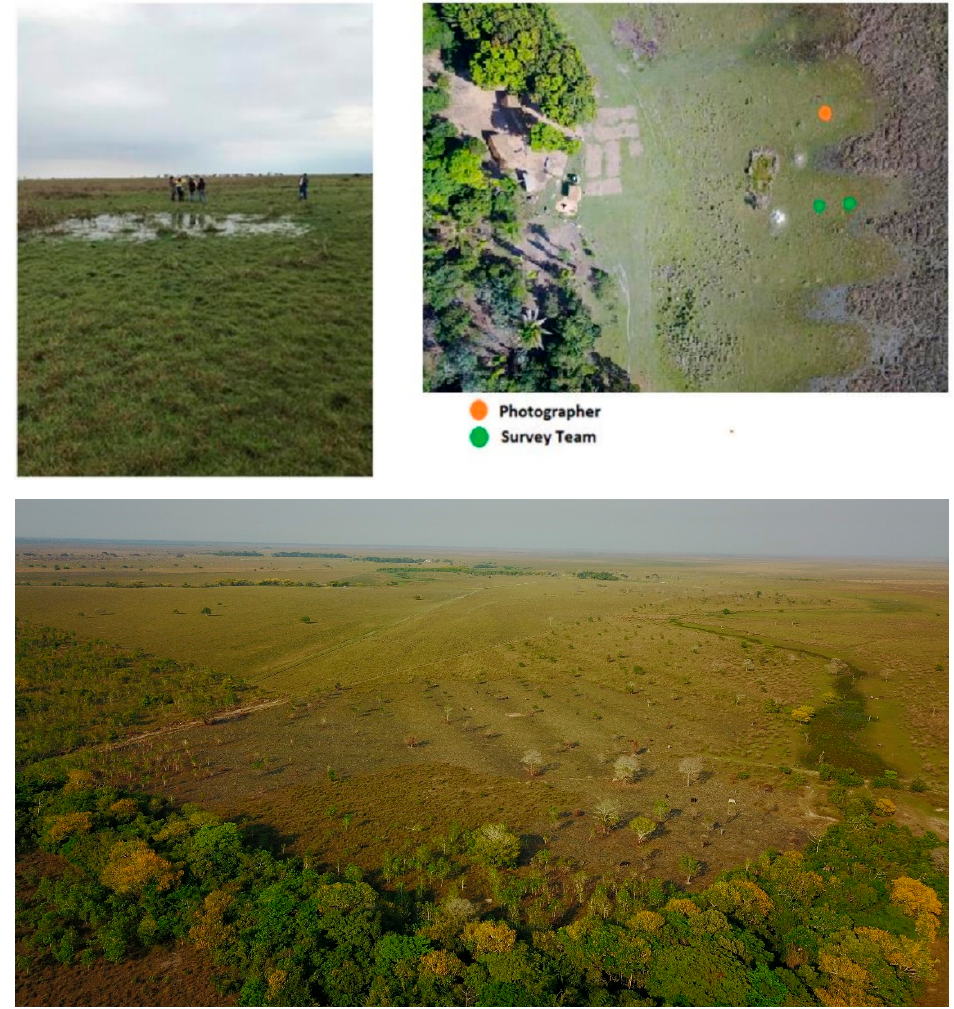
Figure 2. Raised field platforms are difficult to identify from the ground even for someone familiar with their location from aerial photographs. ( top left ) In this photo taken at Miraflores forest island in the Quinato wetland, the photographer is standing on one raised field platform while a research team stands on an adjacent platform. Water in the intervening canal prevents walking between the fields. ( top right ) The same raised fields are photographed with a drone. The locations of the photographer and survey team in the first image are shown. ( bottom ) A group of raised fields in the savanna adjacent to Santa Maria forest island. (photography by Thomas Lee).